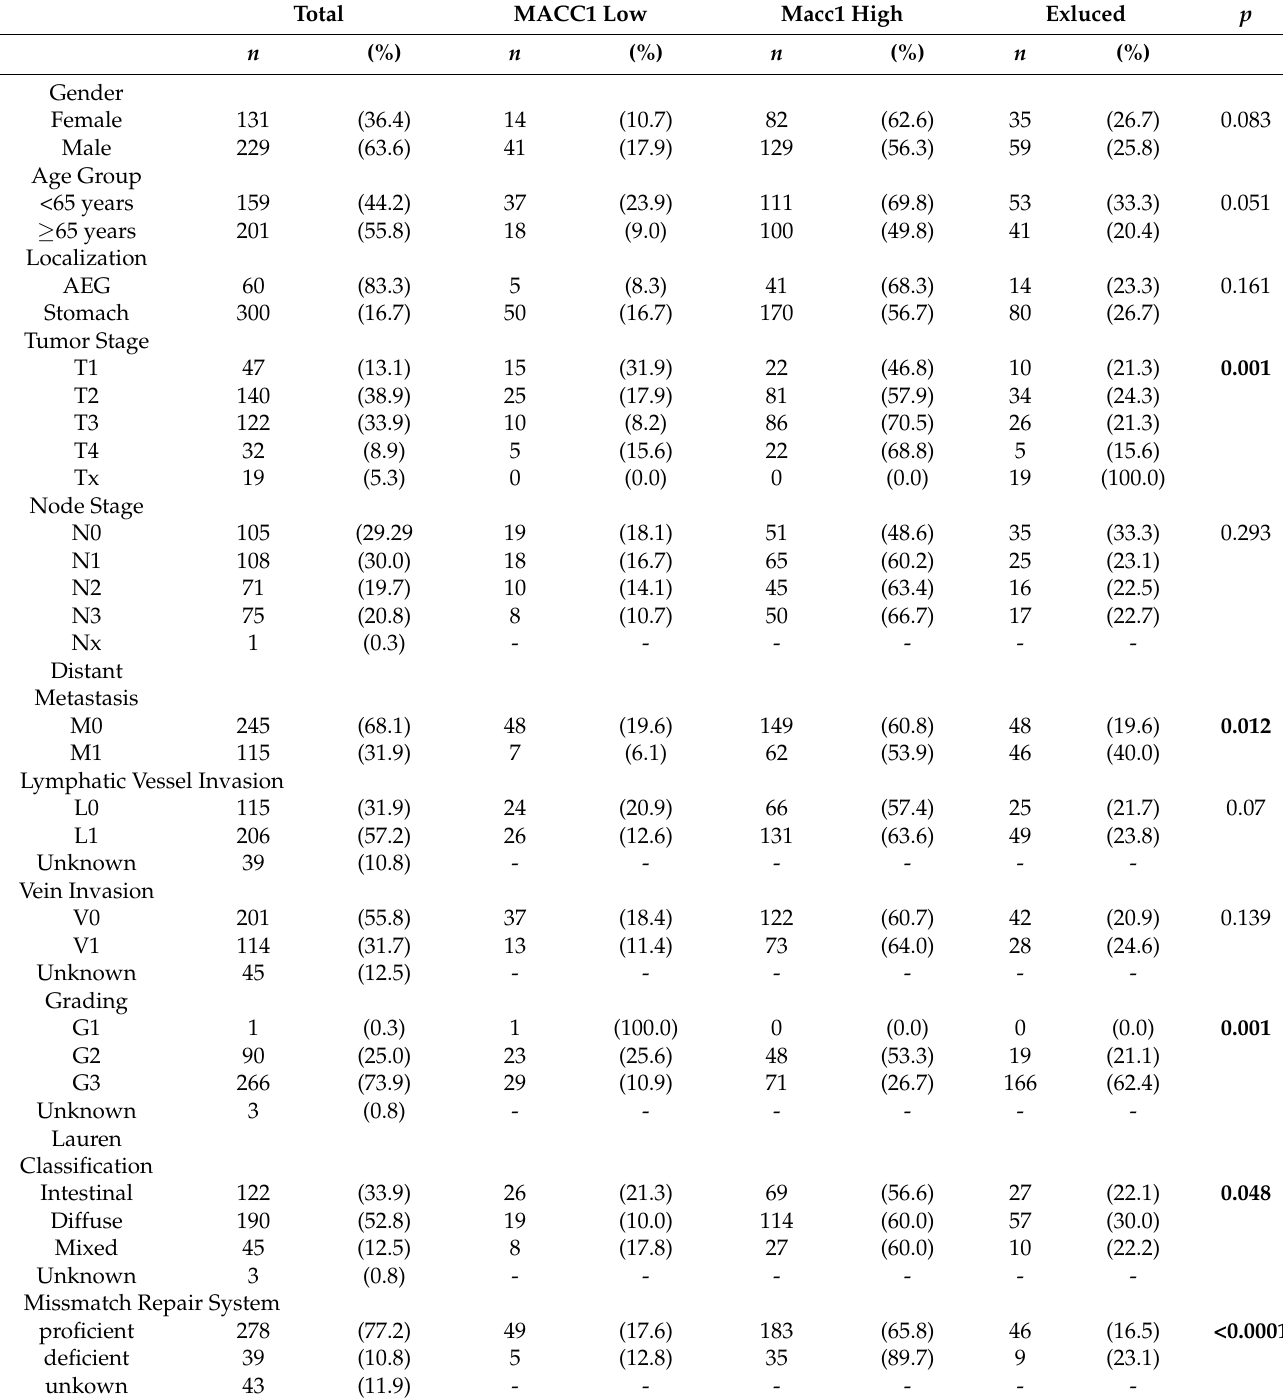
Table 1. Patient characteristics of the analyzed patient cohort and distribution of MACC1-high and MACC1-low tumors. Significance calculated by